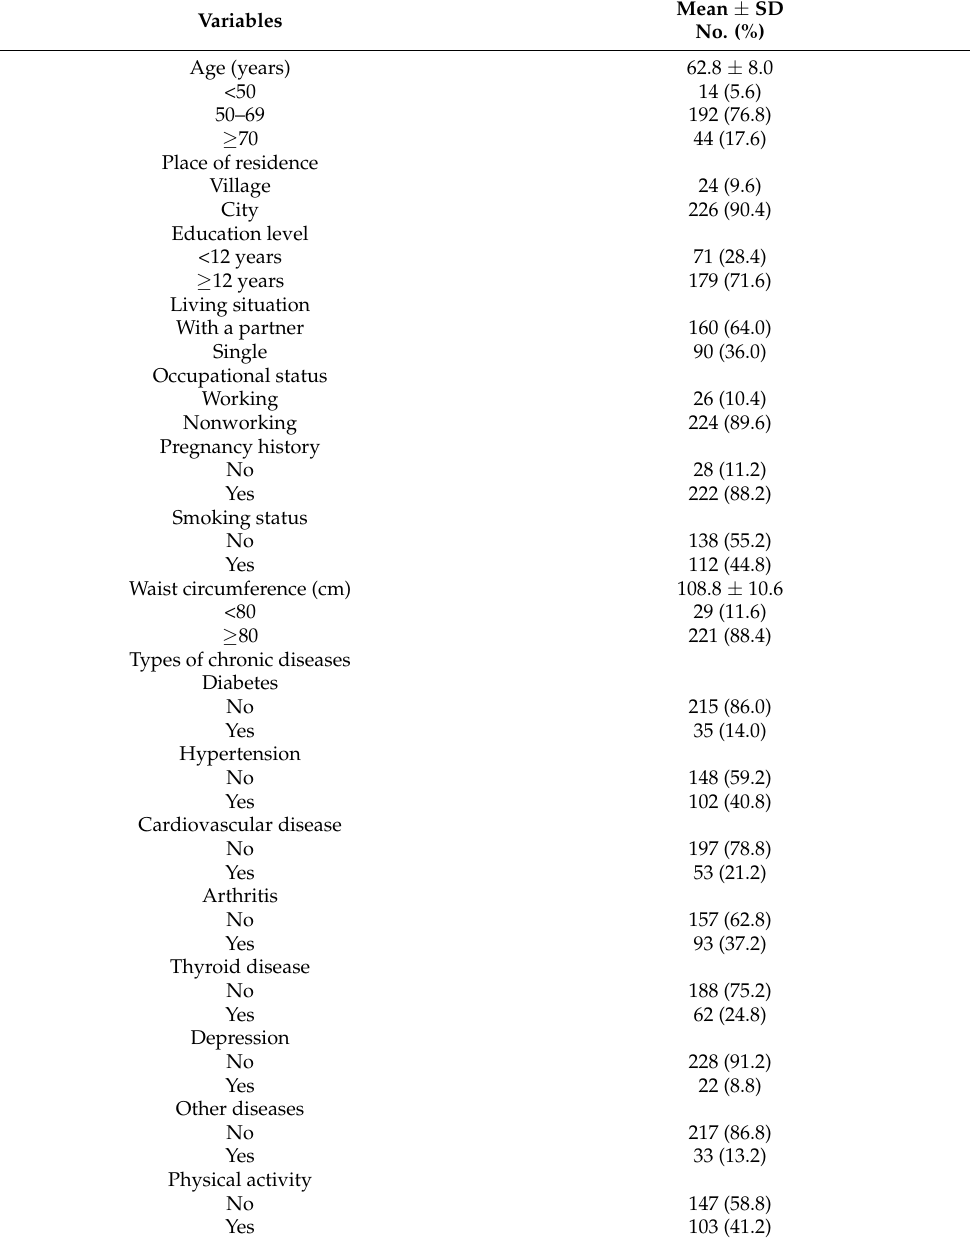
Table 1. Sociodemographic and general health characteristics of the participants ( n =